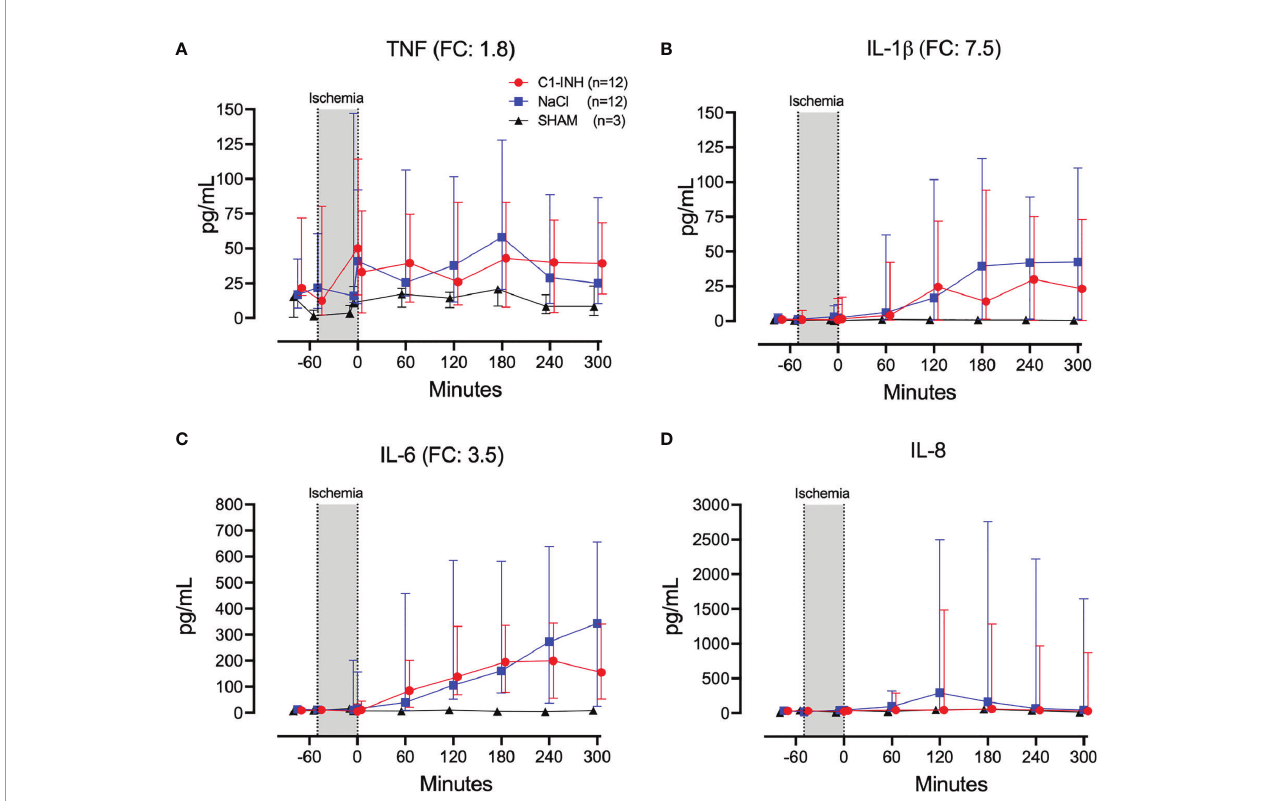
FIGURE 5 | Proin fl ammatory cytokines. (A) Tumour necrosis factor (TNF), (B) interleukin (IL)-1 b , (C) IL-6, and (D) IL-8 were measured in plasma of 24 piglets undergoing clamping of the thoracic aorta at the Th8 level. Upfront 12 piglets received human saline intravenously and 12 received C1-INH (250 IU/kg), respectively. Three sham animals received thoracic opening without clamping. Reperfusion started at 0 minutes and lasted 5 hours. Longitudinal time data are expressed as median and interquartile range. “ Ischemia ” indicates the 45 minutes period of clamping. NaCl and C1-INH-groups were combined when there were no differences in the fold change (FC) calculation. FC is the change from before cross-clamp onset to maximum